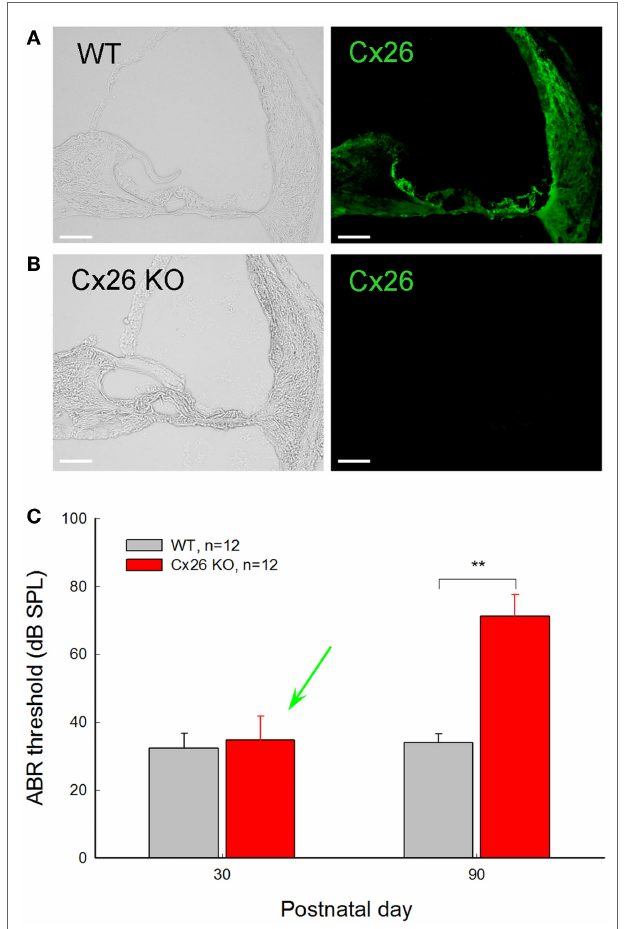
FiGuRe 4 | Normal hearing in young Cx26 KO mice after deletion of Cx26 after birth . (A,B) Immunofluorescent staining for Cx26 in the cochlea in WT and Cx26 KO mice at P30 following deletion of Cx26 at P10. No positive labeling is visible in the Cx26 KO mouse. (C) ABR thresholds of WT and Cx26 KO mice were measured at P30 and P90 following deletion of Cx26 at P10. A green arrow indicates that the ABR threshold in Cx26 KO mice at P30 remained normal, even though the expression of Cx26 in the cochlea was already deleted [see (B) ]. At P90, Cx26 KO mice had a significant increase in ABR threshold, displaying hearing loss. **, P < 0.001, t -test. Scale bars: 50 μ m. Modified from Zhu et al.